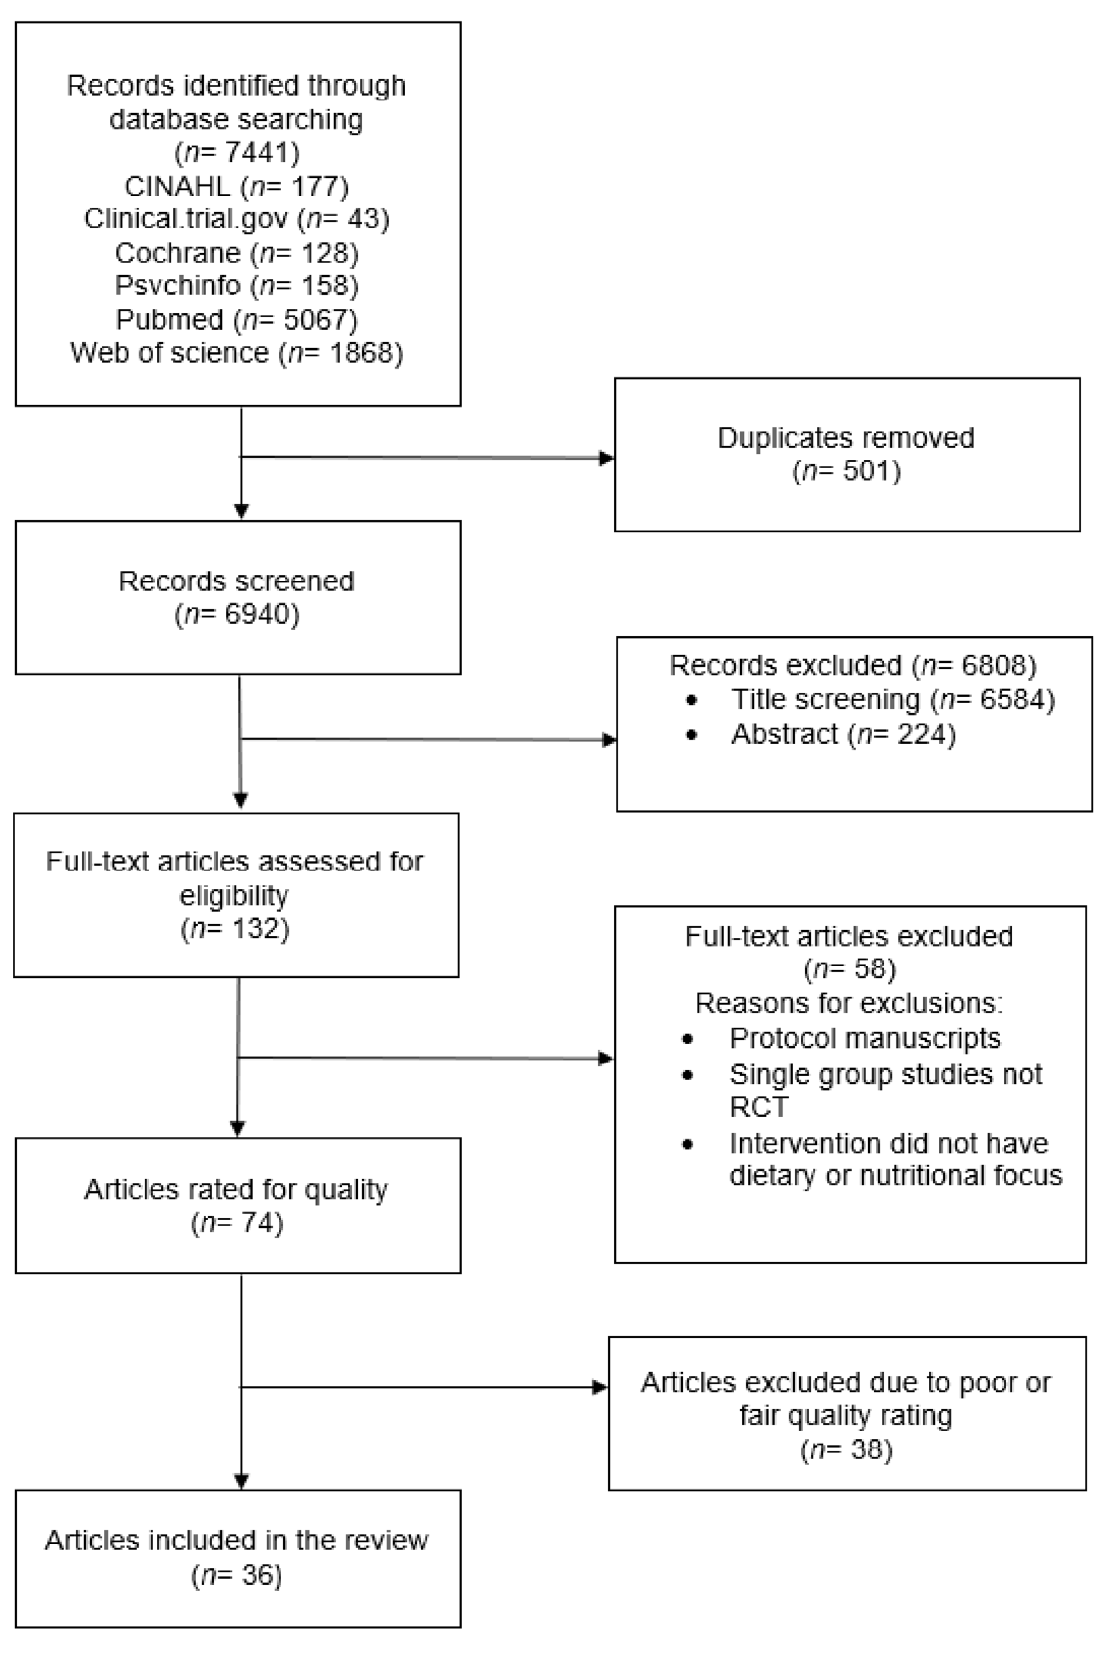
Figure 1. PRISMA